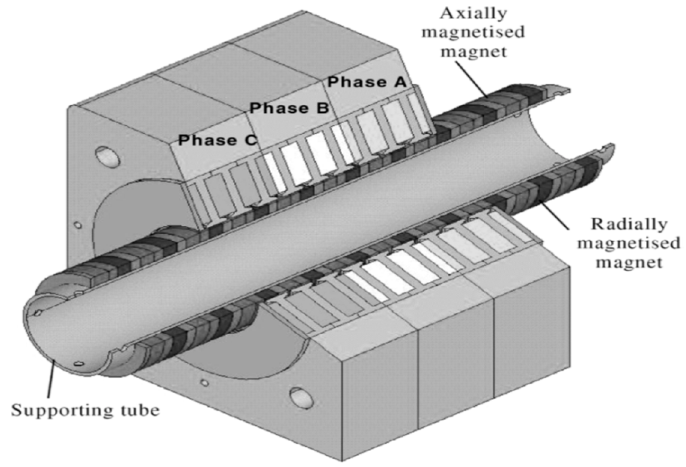
Figure 5. Schematic of three-phase, 10-pole, 9-slot tubular modular PM machine [35].